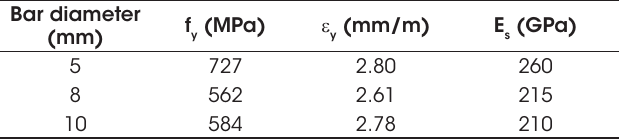
Steel structural properties